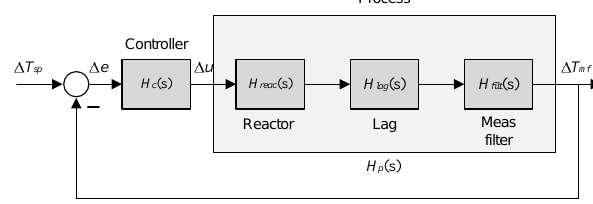
Figure 14: Block diagram of a transfer functions model of the control